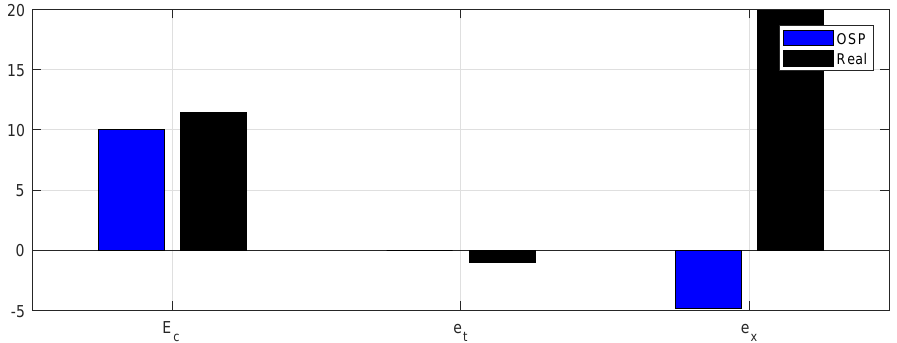
Figure 13. Case B—Real (black) and simulated (blue) energies (kWh), traveling times (s) and distance errors (m).